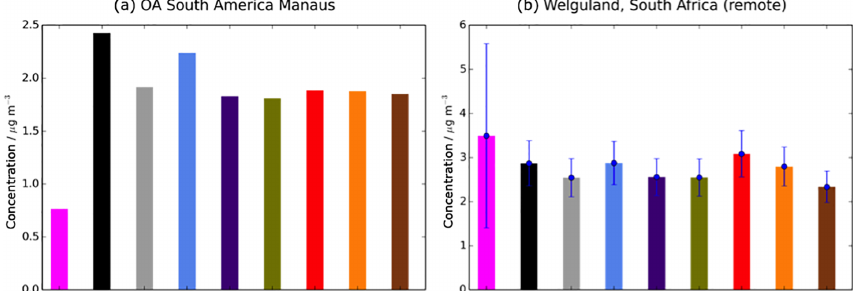
Figure 5. Simulated and observed OA surface concentrations (µgm − 3 ) over remote sites in the SH, (a) Manaus (Brazil), and (b) Welgegund (South Africa). Bars indicate OA concentrations from observed (pink) and simulated from the Control (black), Dry_High (grey), Wet_Low (blue), DryH_WetL (purple), Multi_nap (green), Multi_nap_yield (red), Multi_tol_yield (yellow), and Multi_benz_yield (brown) simula- tions, described in Table 3. For Welgegund, both observed and simulated monthly mean OA concentrations span an entire year. The standard deviations across this year, based on the monthly-mean data, are indicated in blue. For Manaus, however, the measurements of OA only span 1 month, hence no standard deviation is shown for this